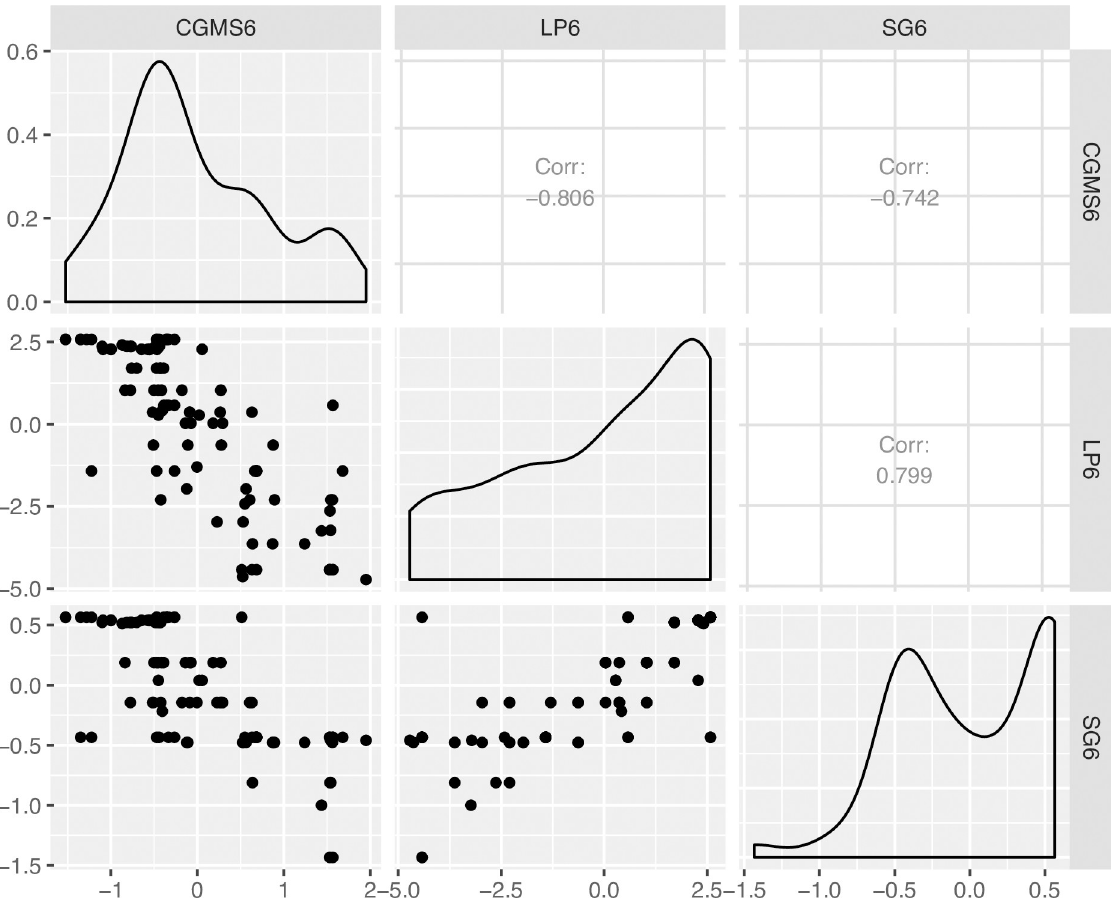
Fig 1. Phenotypic distribution and correlation coefficients for cassava green mite severity and other associated traits.